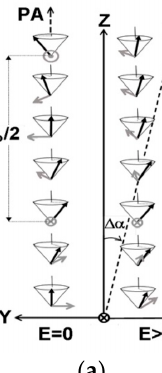
(c) Figure 14. Schematic representation of geometry of a vertically aligned DHF cell [40]: ( a ) 1—glass plates, 2—in-plane electrodes, 3—smectic layers parallel to glass substrates, 4—a voltage generator. ( b ) The chemical structure of stearic acid chromium salt. ( c ) The texture of Vertically aligned DHFs (VADHF) cell placed between crossed polarizers at V = 0 V. The red mark is 20 μ m.